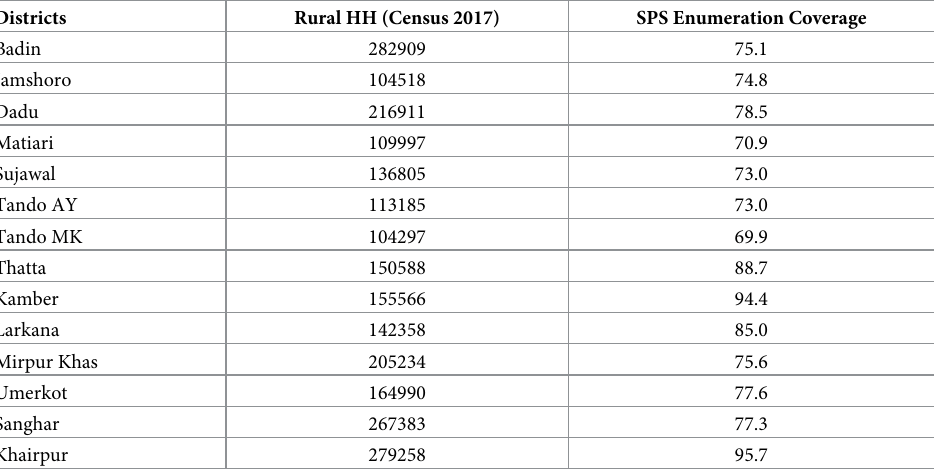
Table 1. Simple Poverty Score coverage in